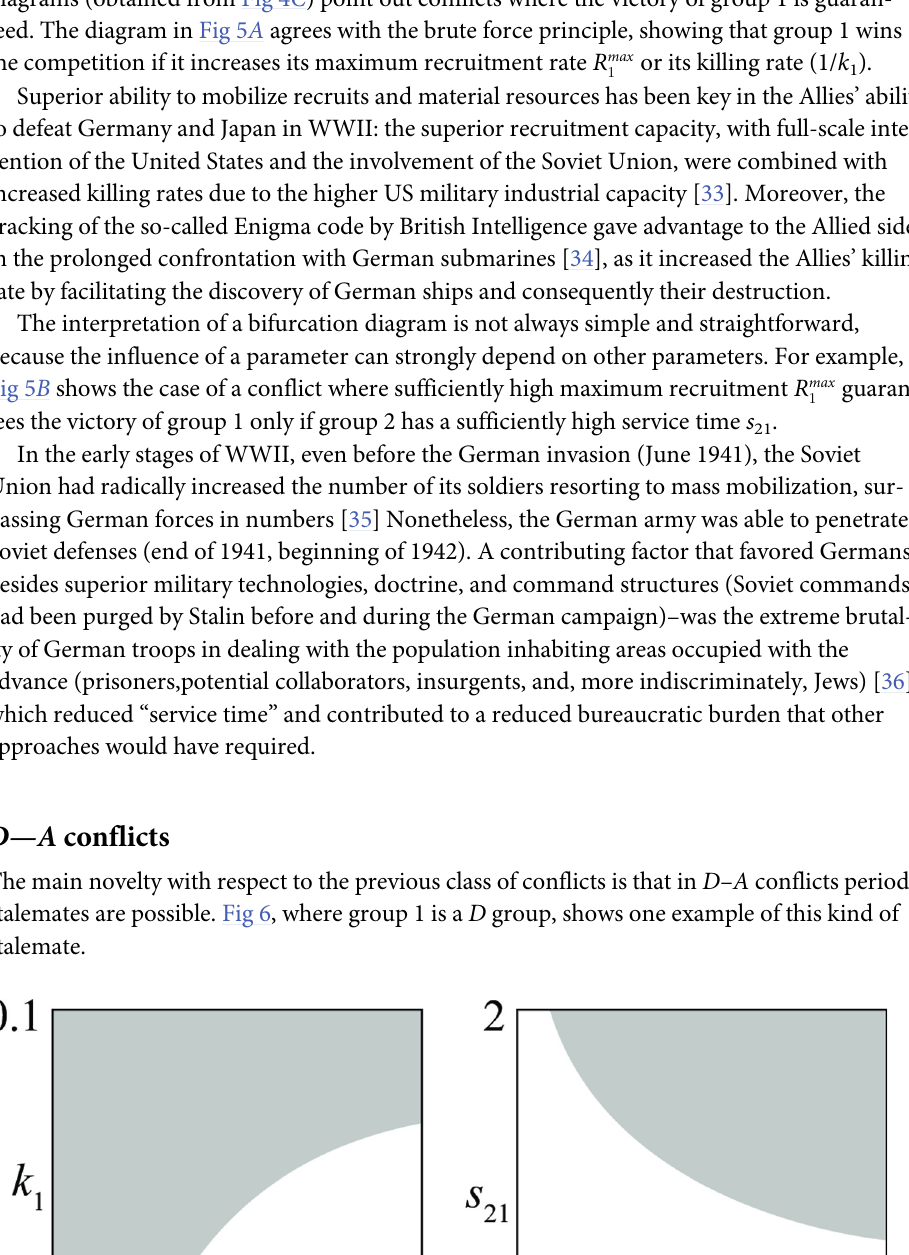
PLOS ONE | https://doi.org/10.1371/journal.pone.0264418 March 4,